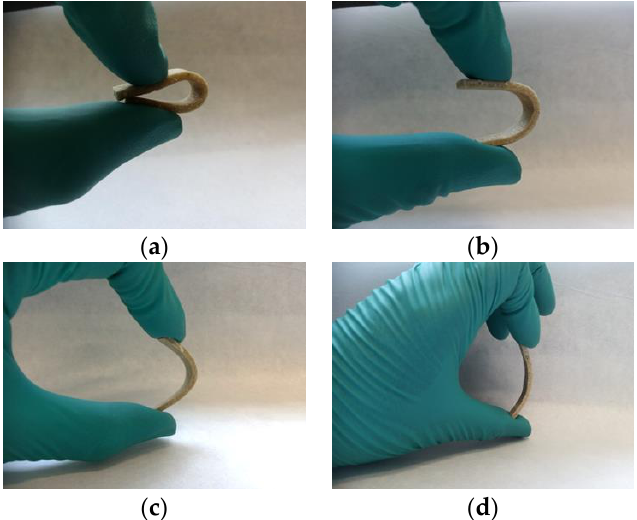
Figure 10. Maximum bending of keratin-based TPUU-SS/CFs biocomposites containing different loadings of CF: ( a ) 40 wt %, ( b ) 50 wt %, ( c ) 60 wt % and ( d ) 75 wt %.